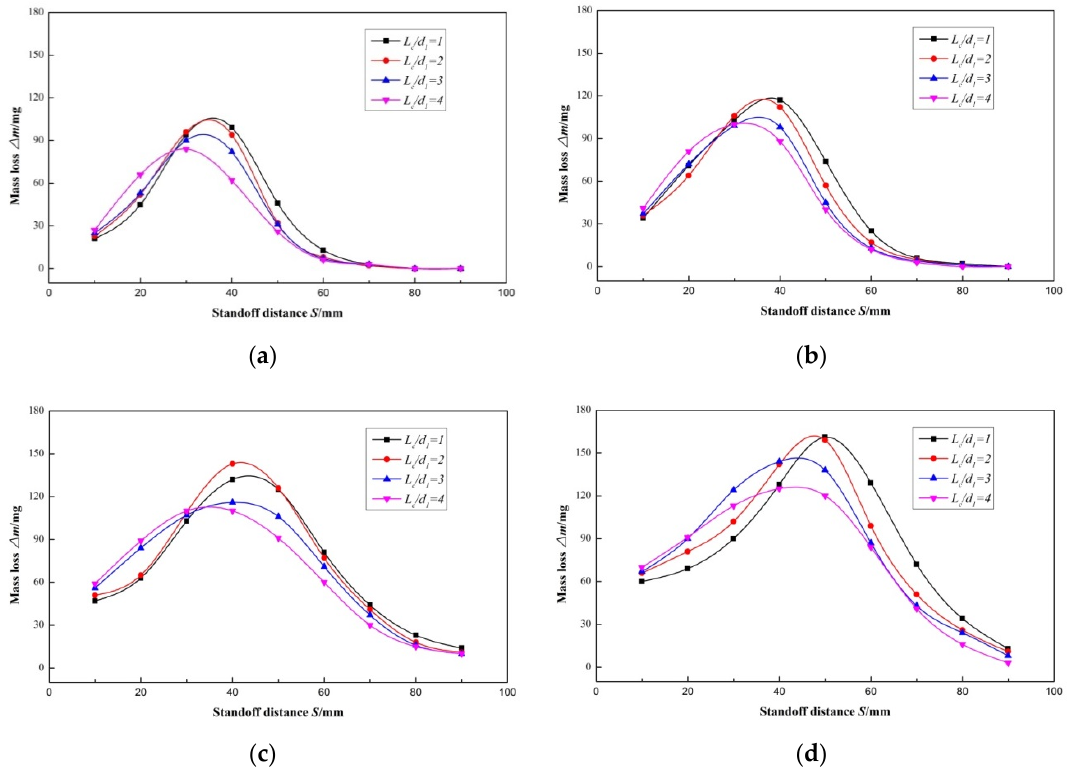
Figure 13. Mass loss as a function of standoff distance under different cavity length. ( a ) P o = 10 MPa; ( b ) P o = 15 MPa; ( c ) P o = 20 MPa; ( d ) P o = 25 MPa.